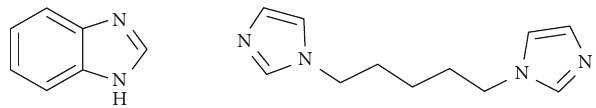
Figure 1: Schematic representation of the benzimidazole and 1,6- bis(imidazol)hexane organic compounds used in this research.